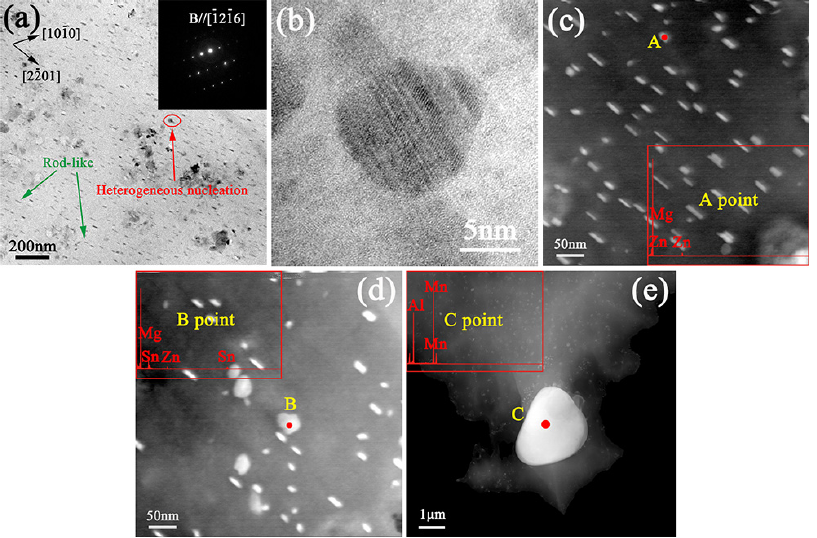
Figure 6. TEM micrographs of the single-aged ZTM641-1Al alloy, ( a ) Bright-field (BF) TEM image, taken along the [ 12 16] α -Mg zone axis, ( b ) HRTEM image of “T” phase ( c – e ) HAADF-STEM image, inset: corresponding EDS results of the points.